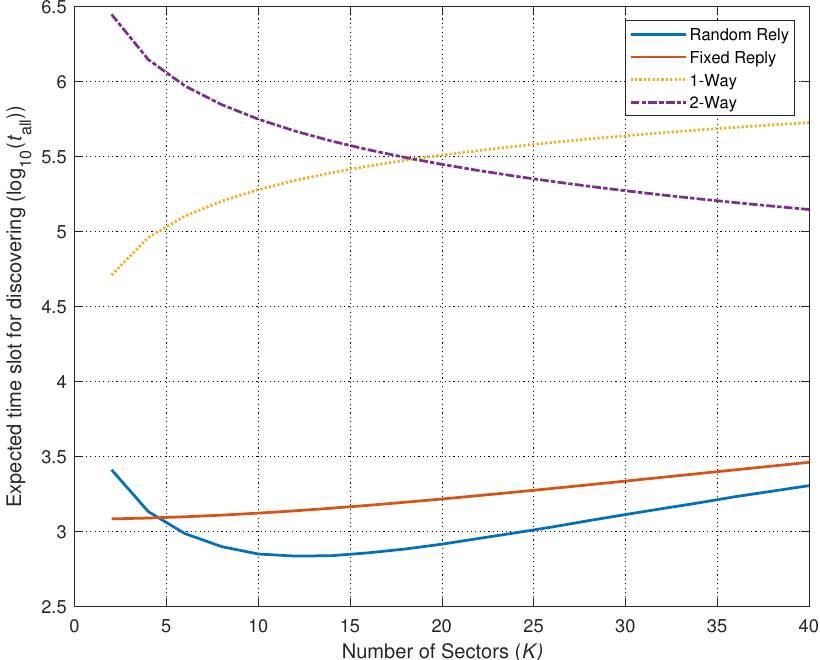
Figure 12. Time for discovery with different K. ( N = 1200).